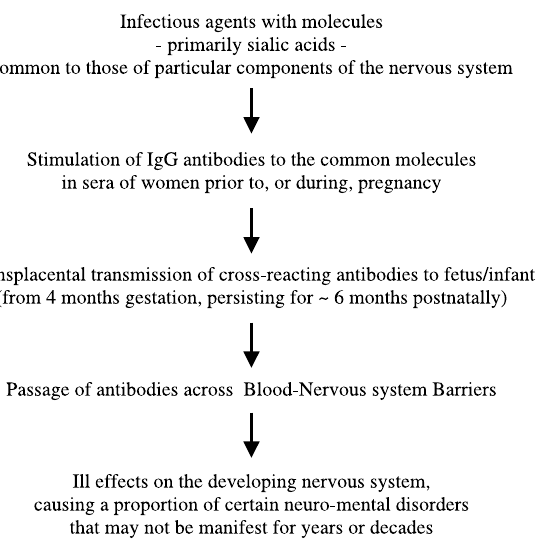
Figure 1. A simplified version of the Gestational Neuro-Immunopathology (GENIP) Hypothesis, emphasizing that the NMD that might occur (have its origin?) during neural development of the fetus/infant may not become clinically manifest until years or decades